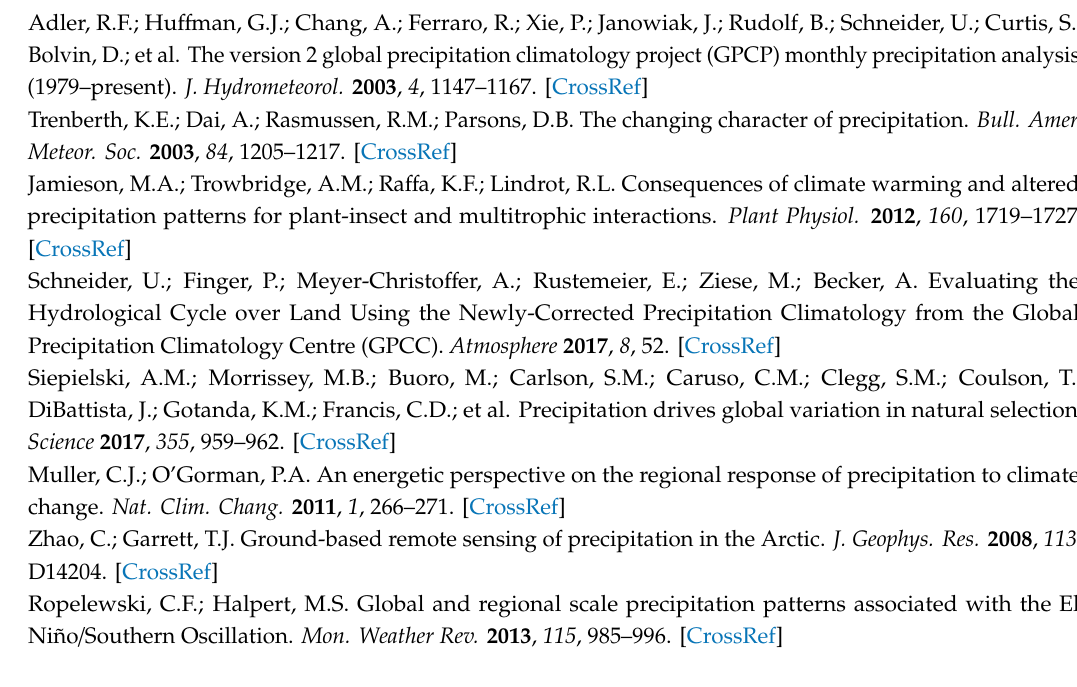
Figure S1: The decadal trend of the relative change of precipitation occurrence frequency for di ff erent types of precipitation in four seasons over South China (S) region, where P represents precipitation rate. Figure S2: The decadal trend of the relative change of precipitation occurrence frequency for di ff erent types of precipitation in four seasons over the North China (N) region, where P represents precipitation rate. Figure S3: The decadal trend of the relative change of precipitation occurrence frequency for di ff erent types of precipitation in four seasons over the Northeast China (NE) region, where P represents precipitation rate. Figure S4: The decadal trend of the relative change of precipitation occurrence frequency for di ff erent types of precipitation in four seasons over the Tibetan Plateau (TP) region, where P represents precipitation rate. Figure S5: The decadal trend of the relative change of precipitation occurrence frequency for di ff erent types of precipitation in four seasons over the Northwest China (NW)